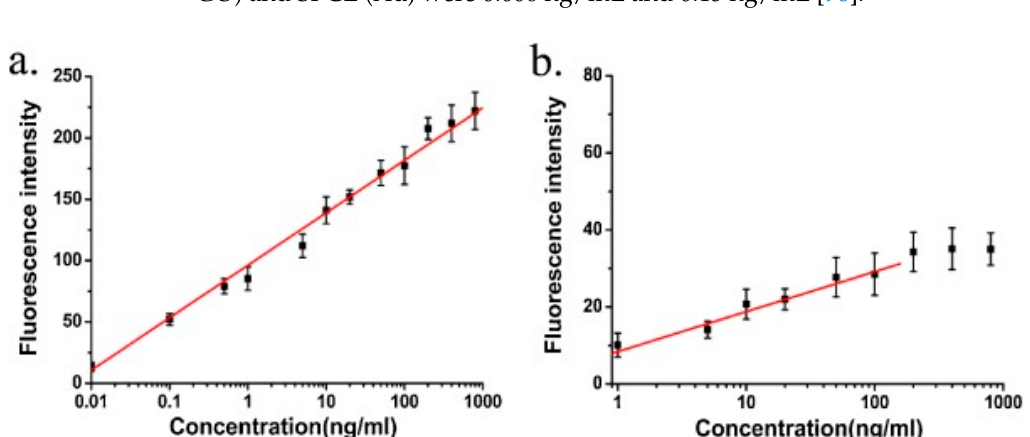
Figure 26. Dependences of the fluorescence intensities of ( a ) SPCE (Au+GO) and ( b ) SPCE (Au) on the concentration of human IgG (adapted with permission from Reference [96], copyright Elsevier).